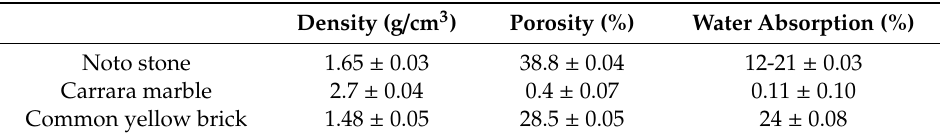
Table 1. Physical properties of the selected materials.